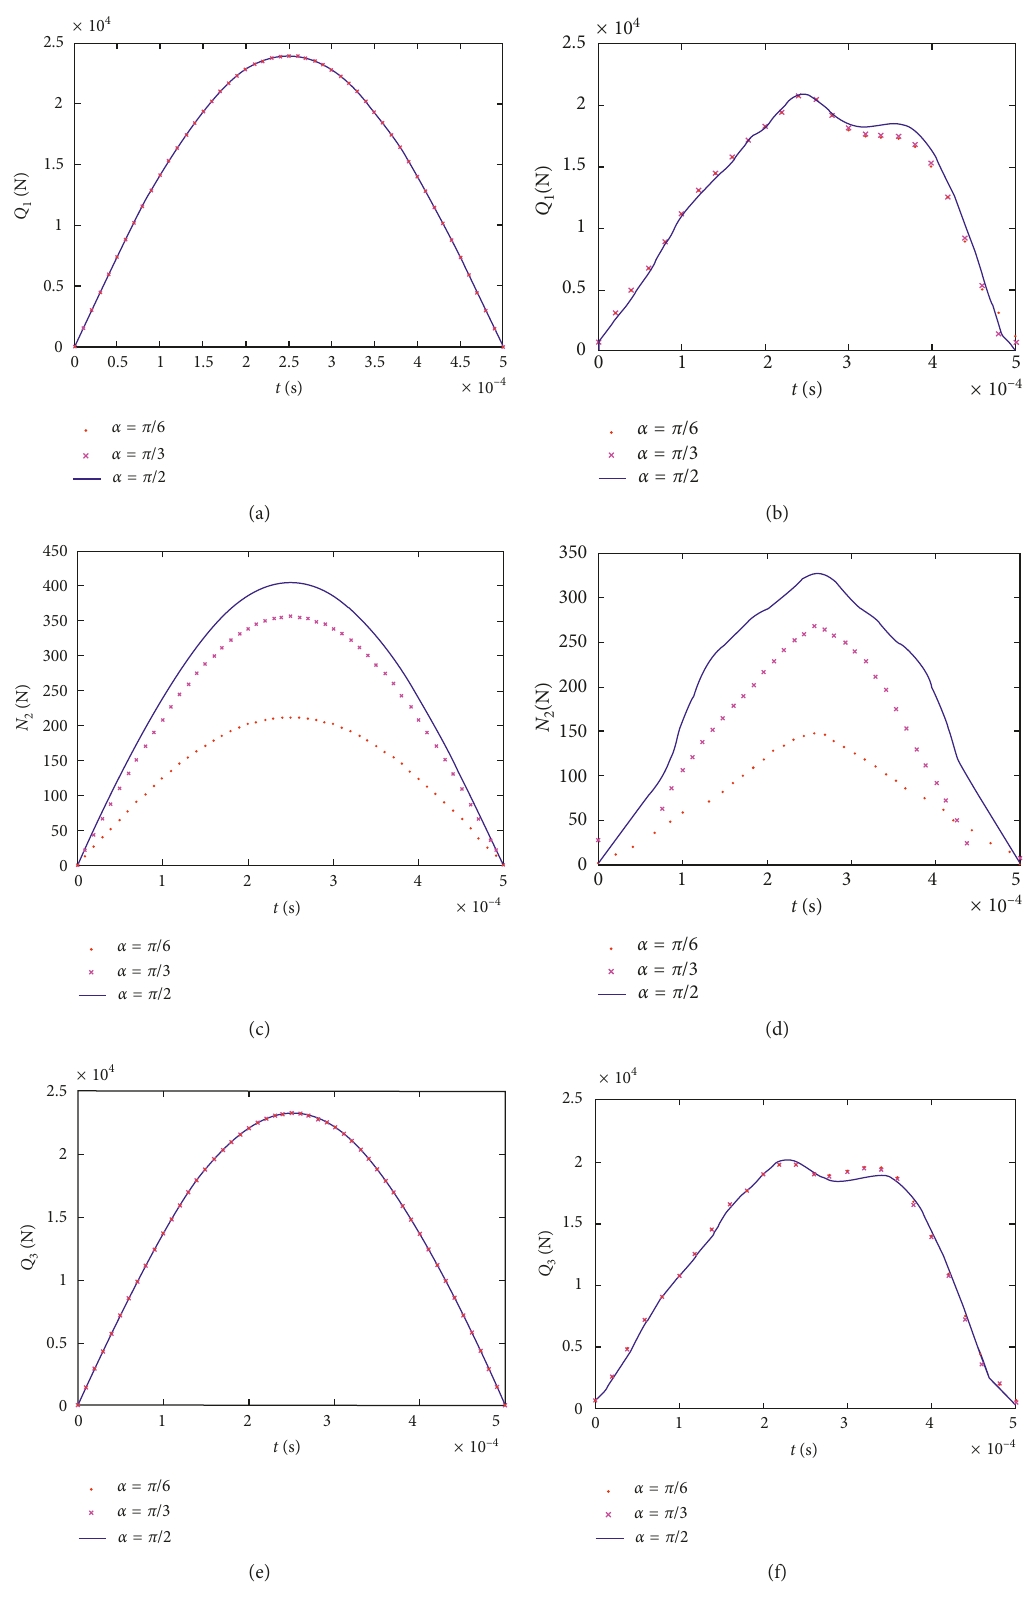
Figure 4: Effect of α on the internal force of the joint ( β 0). (a) Q 1 by theoretical analysis. (b) Q 1 by finite element analysis. (c) N 2 by (cid:31) theoretical analysis. (d) N 2 by finite element analysis. (e) Q 3 by theoretical analysis. (f) Q 3 by finite element